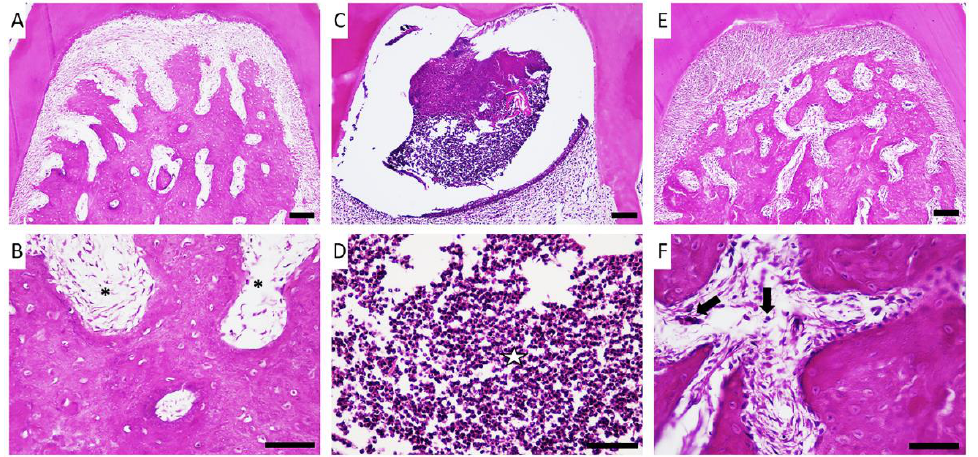
Figure 2. Effects of copaiba oleoresin (200 mg/kg/day for 7 days) in the furcation region of the first